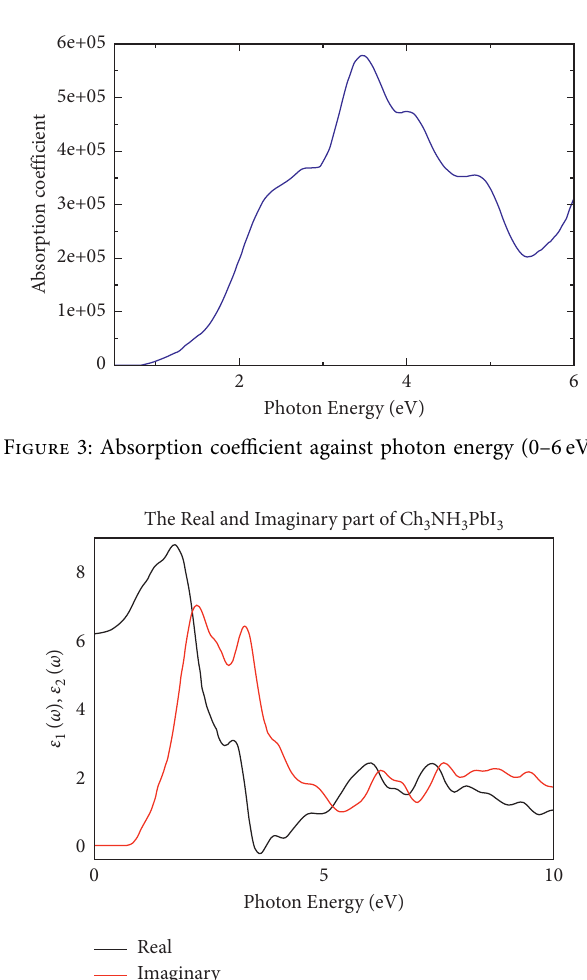
1 ( ω ) and imaginary ε 2 ( ω ) part against the photon